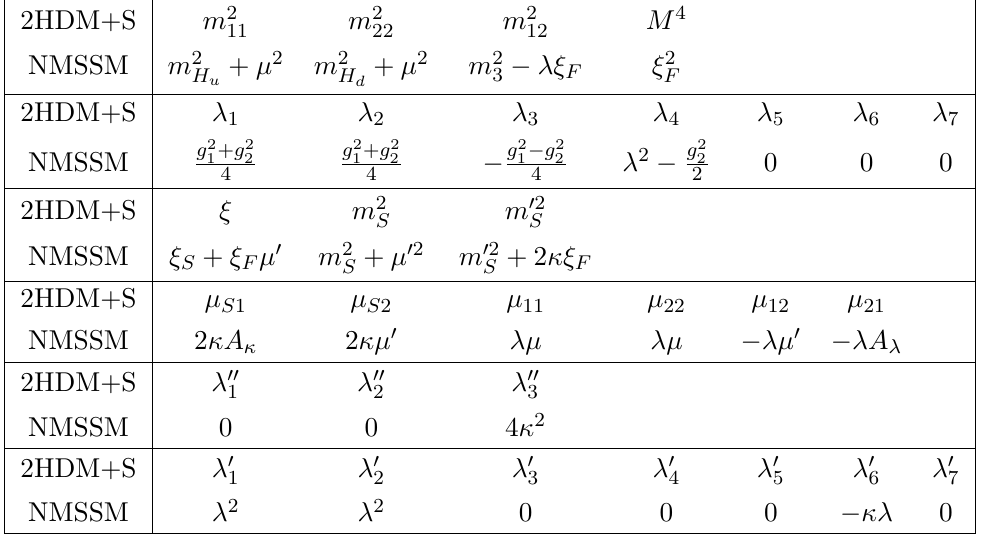
Table 3 . Mapping of the 2HDM+S parameters to the general NMSSM. The Z 3 NMSSM is obtained by setting (cid:22) = (cid:22) 0 = m 2 = m 0 2 = (cid:24) F = (cid:24) S = 0. 3 S Open